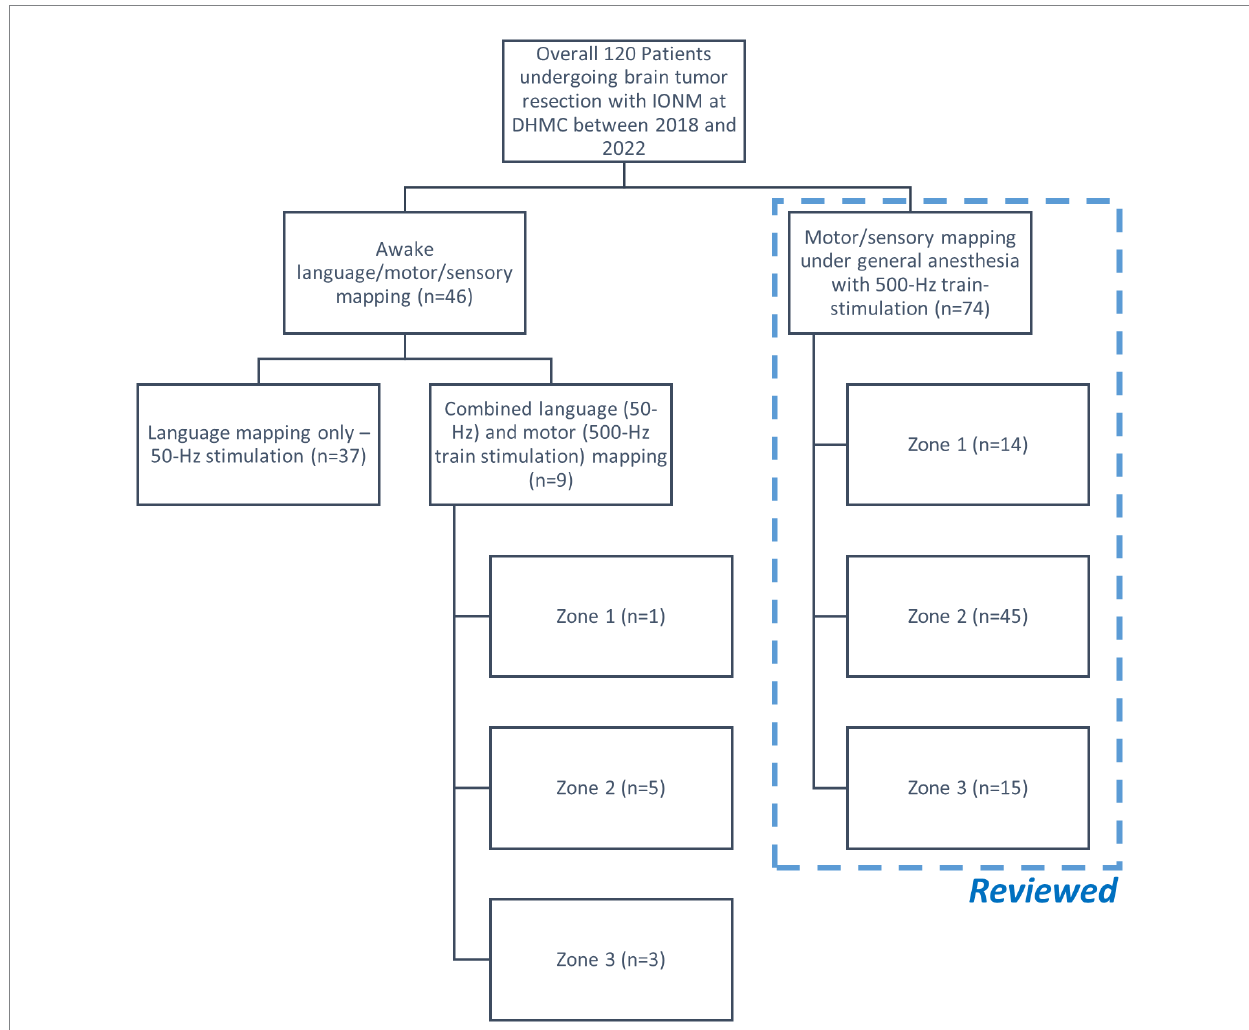
FIGURE 2 Flow chart of the retrospective cohort study. The patient in the highlighted case, which was not included in this chart, underwent motor mapping in Zone 1 under general anesthesia. Only the cases performed under general anesthesia were included for further